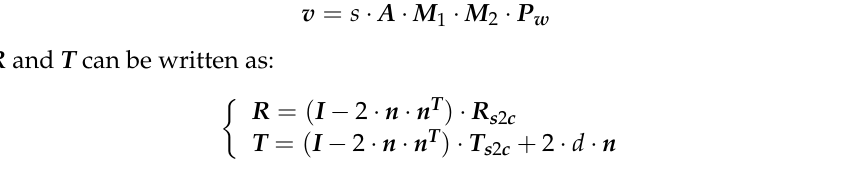
According to the Equation (5), we need at least three specular reflection images to calculate R s 2 c and T s 2 c